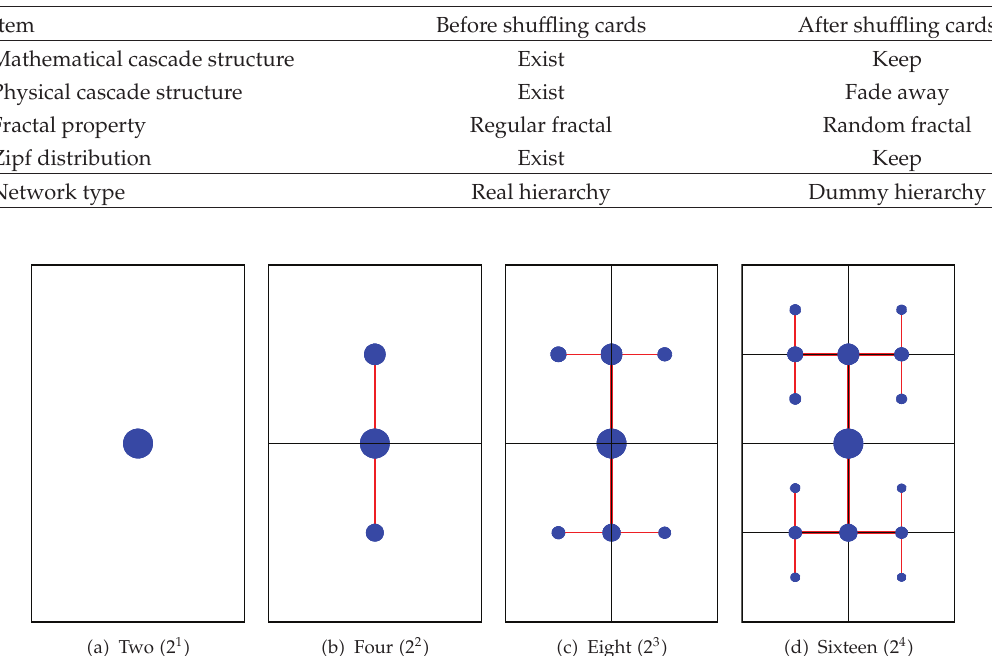
Table 6: Comparison of hierarchy model between the cases before and after shu ffl ing cards.